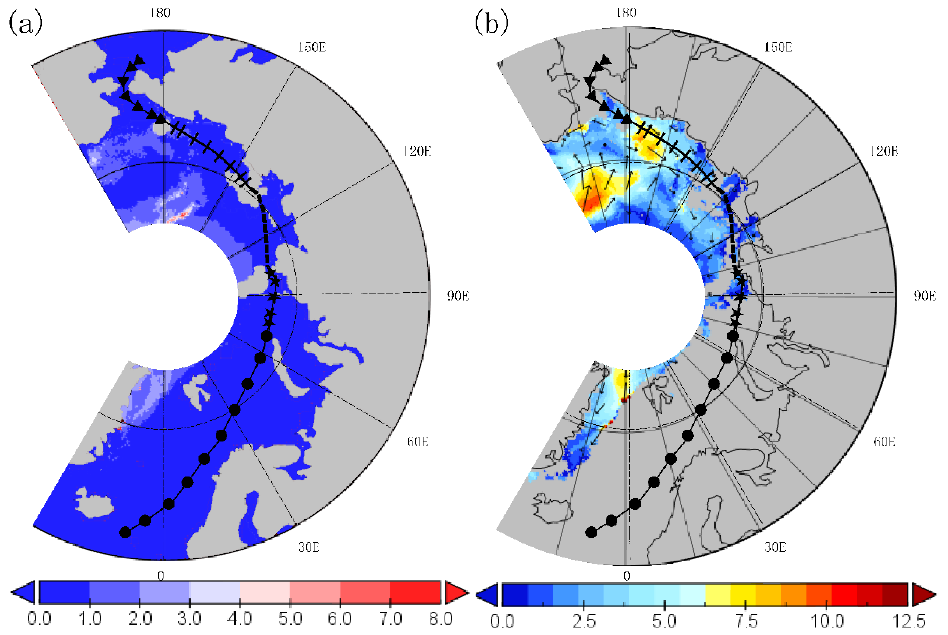
Figure 21. The sea ice age ( a ) and sea ice movement ( b ) of the NEP in the Arctic summer in 2012.